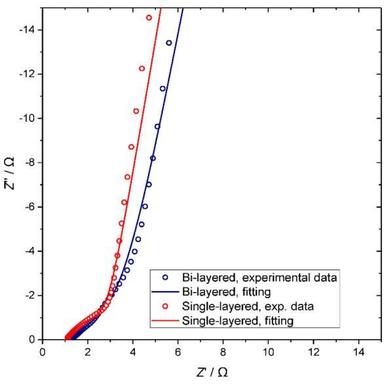
EIS spectra of single- and bi-layered symmetric cells at 0% SOC.